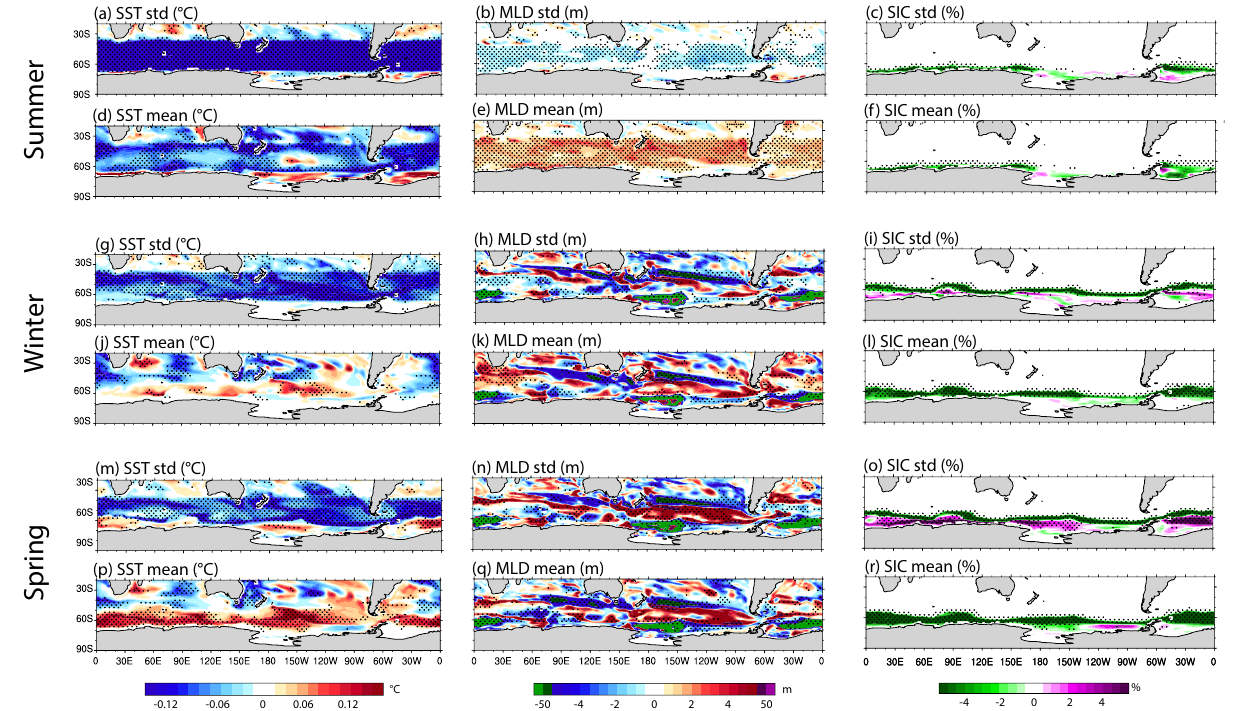
Figure 3. Seasonal standard deviation and mean-state differences (SOclimSST minus CTRL) for: (top two rows) late summer (JFMA), (middle two rows) winter (MJJA), and (bottom two rows) spring (SOND). (left columns) SST, (middle columns) MLD, (right columns) SIC. As in Fig. 1, stippling indicates robustness in the sign of the ensemble-mean difference, where the sign of all six individual differences (each SOclimSST run minus each CTRL run) is the same. Figure produced using the NCAR Command Language (https:// doi. org/ 10. 5065/ D6WD3